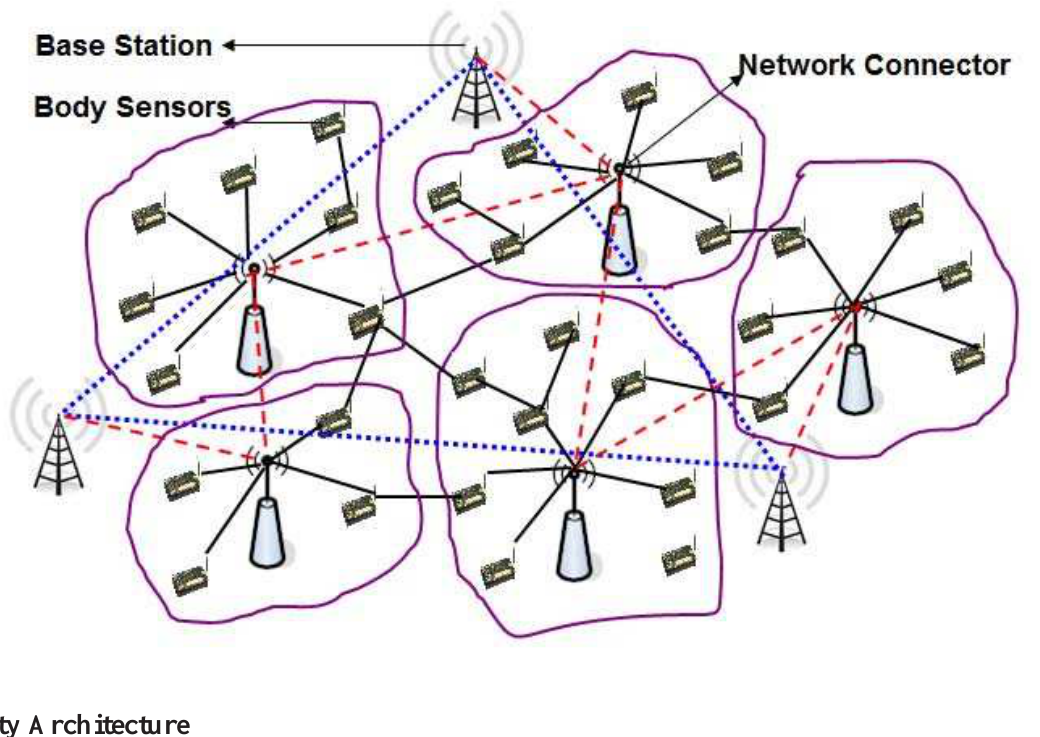
Figure 4. Logical view of the three tiered network architecture of